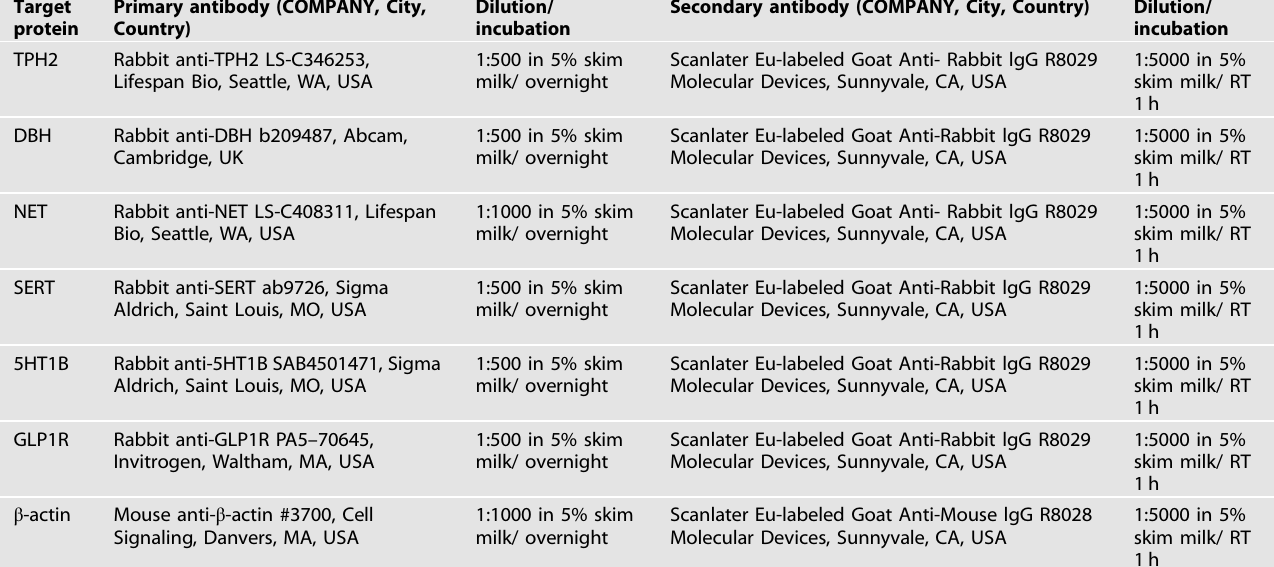
Description of the selected proteins as well as primary/secondary antibody, dilutions and incubation times used. Tyrosine Hydroxylase Isoforms 2 (TPH2), Dopamine β Hydroxylase (DBH), Norepinephrine Transporter (NET), Serotonin Transporter (SERT), 5-hydroxytryptamine receptor 1B (5HT1B), Glucagon-like peptide 1 receptor (GLP1R).